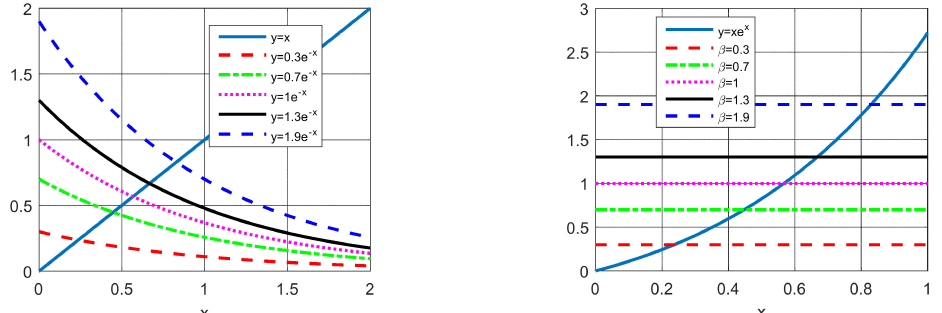
Figure 3. Lambert’s W